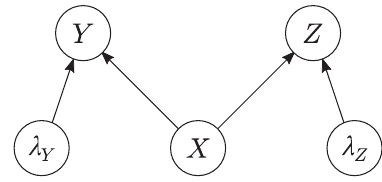
FIG. 2. The causal structure of Fig. 1, expanded so that Y and Z each have a latent variable as a causal parent in addition to X , so that both Y and Z can be made to depend functionally on their